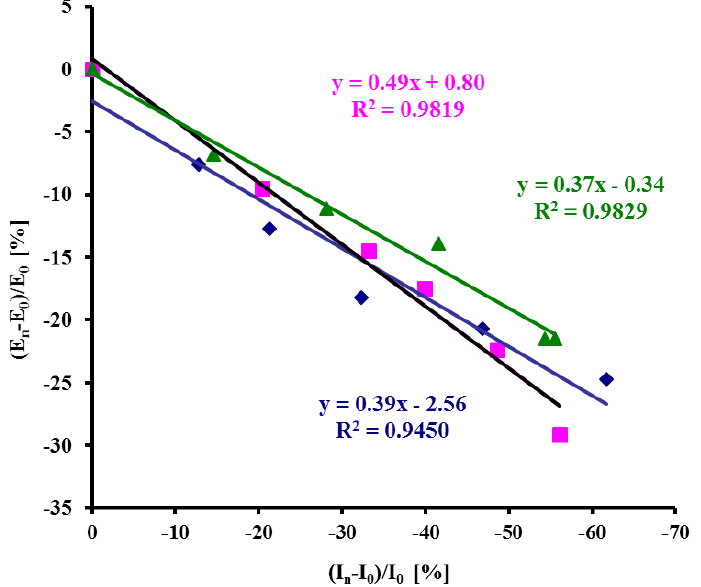
Figure 7. The relationship of the relative Cu(II) redox current decrease and the peak potential shift (%) vs. the concentration of S100B